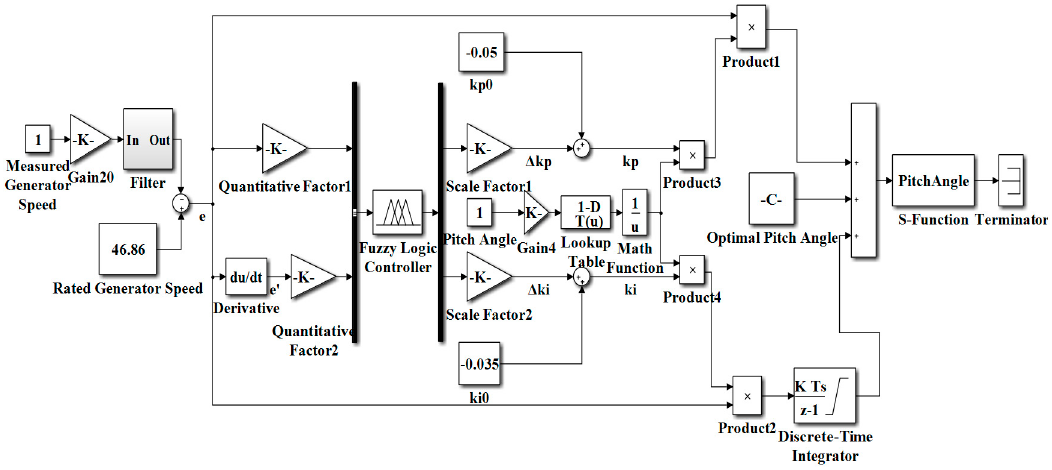
Figure 4. Block diagram of Fuzzy-PI control Simulink.